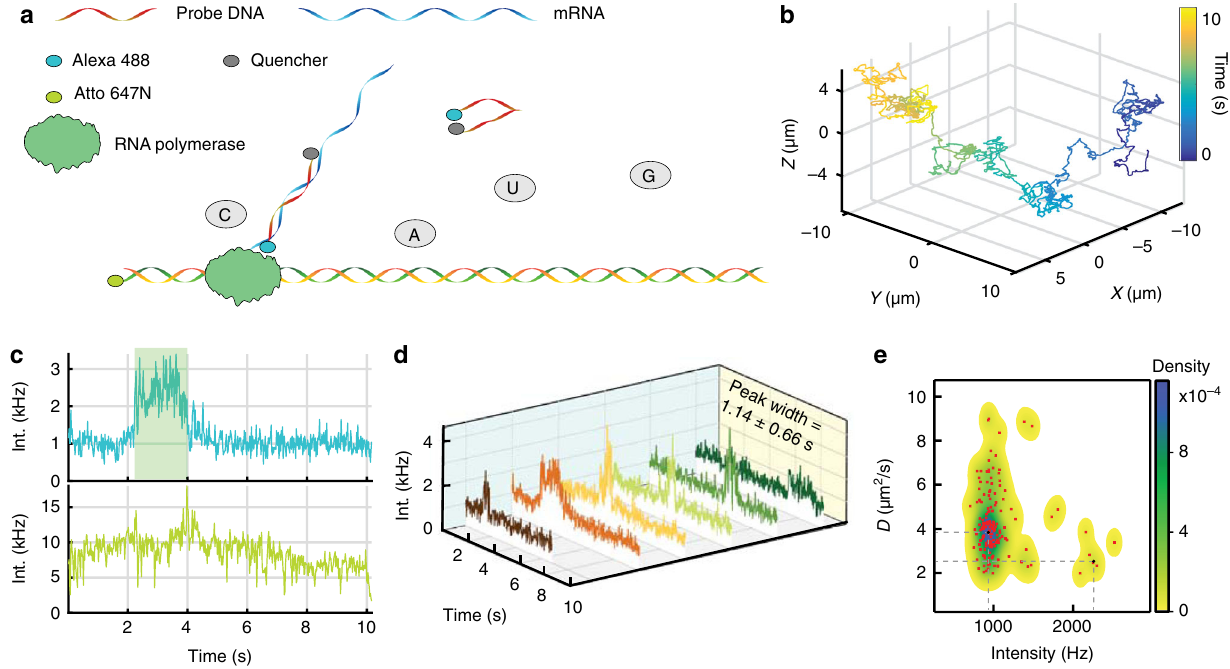
Fig. 4 Real-time measurement of transcription on single, freely diffusing dsDNA. a Solution-phase single-molecule transcription is performed by labeling 1218 bp DNA with Atto 647 N and adding rNTPs and E.coli RNA polymerase in 22 wt% glycerol. The transcribed RNA is sensed using a complementary ssDNA with Alexa 488-Iowa Black fl uorophore-quencher pair. The ssDNA is quenched in its unpaired state and becomes fl uorescent upon pairing with RNA. b 3D trajectory of dsDNA in transcription buffer. c Intensity of dsDNA from ( b ) (bottom) and the observed transcription burst from the ssDNA probe (top, highlighted with light green shadow). d Six transcription bursts from the ssDNA probe produce an average burst duration of 1.14 ± 0.66 s. e 2D scatter plot of photon counts of mRNA channel versus diffusion coef fi cient of template double strands DNA. 6 trajectories in ( d ) are used to produce this plot. The underlying density map is visualized using 2D kernel density estimation. Density <10 − 5 is shown as white. Two density peaks (corresponding to the inactive and active transcription states) are marked with the black dot and dotted gray lines. The higher intensity spots (to the right) correspond to active transcription state while lower intensity spots (to the left) correspond to the inactive transcription state. The photon counts and diffusion coef fi cient are calculated with 500 ms bin